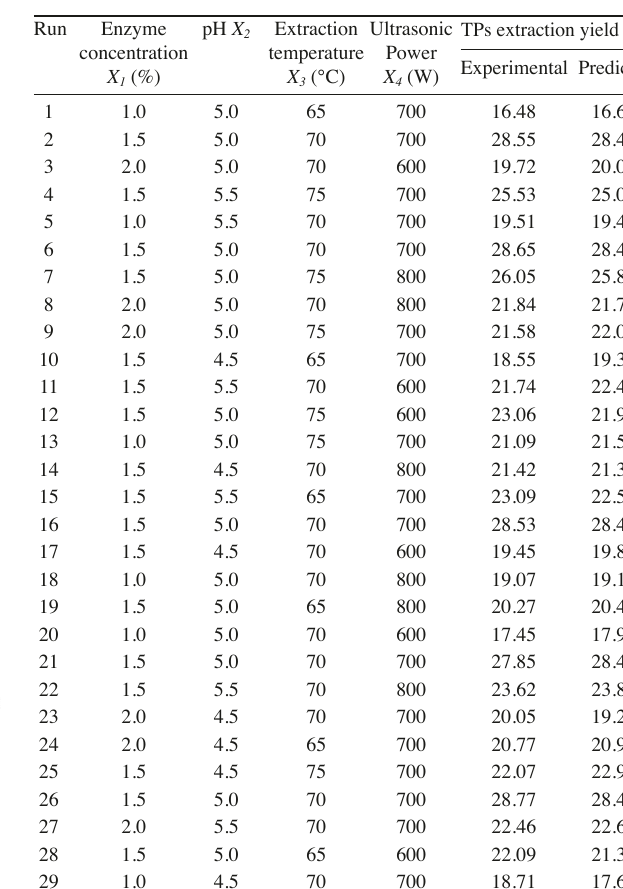
Tab. 2: Central composite design with the observed responses and predicted values for yield of tea